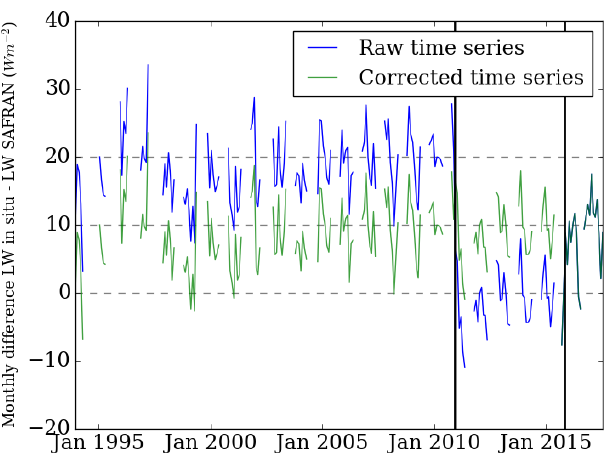
Figure 5. Monthly average of the difference between measured downward longwave (LW) and SAFRAN estimates. The two ver- tical black lines indicate the sensor changes (cf. Table 2). The blue lines correspond to the raw time series and the green one to the cor- rected time